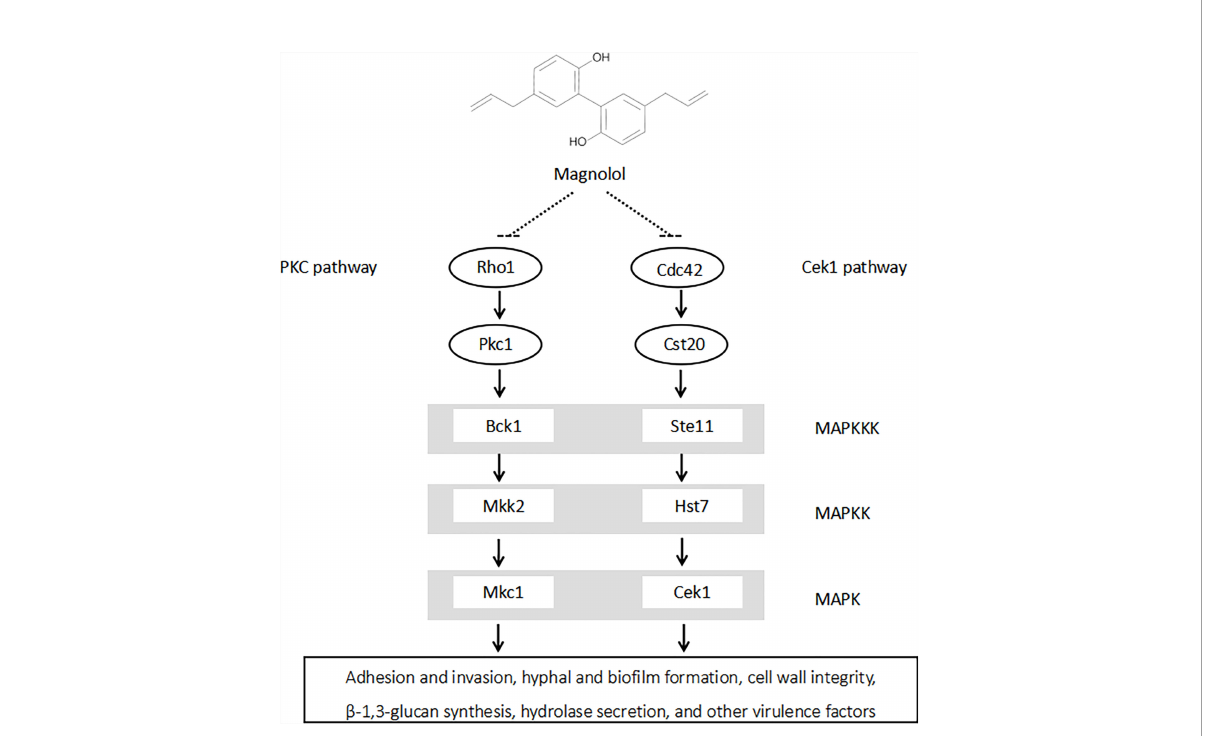
FIGURE 7 Magnolol could signi fi cantly inhibit multiple C. albicans virulence factors by down-regulating PKC and Cek1 MAPK signaling